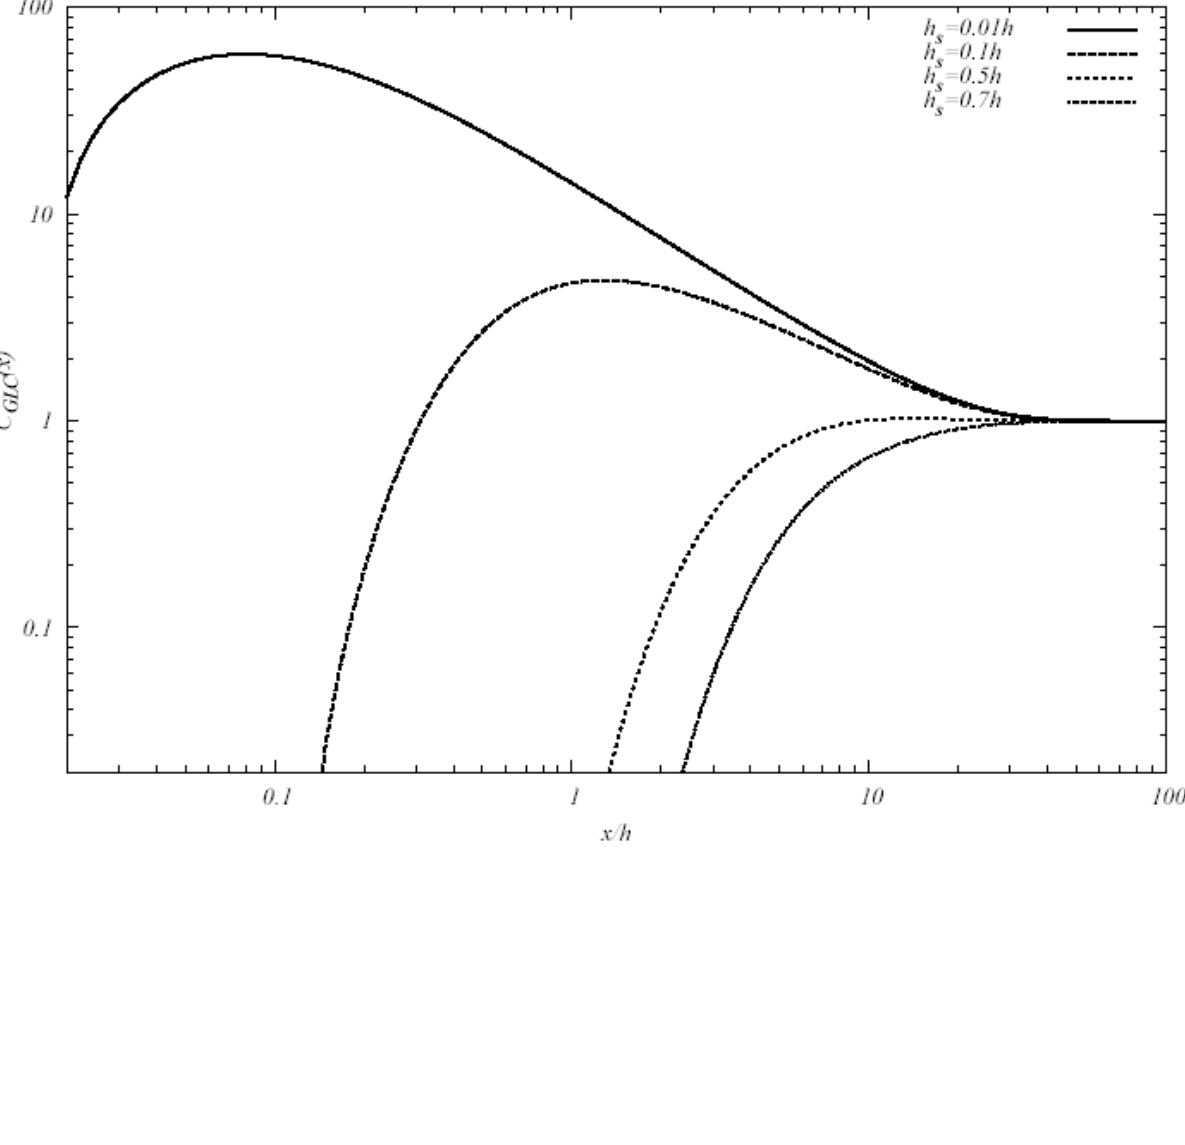
/~  . Four 7.0,5.0,1.0,01.0~ 03.0~ h and L . A maximum   s MO